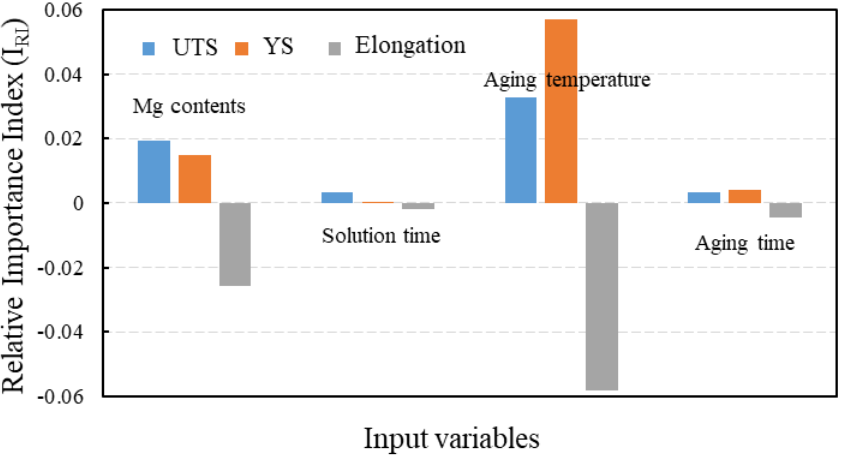
Figure 5. Bar charts showing the index of relative importance of Mg content and heat treatment parameters on UTS, yield strength (YS), and elongation of the Al–7Si alloy.